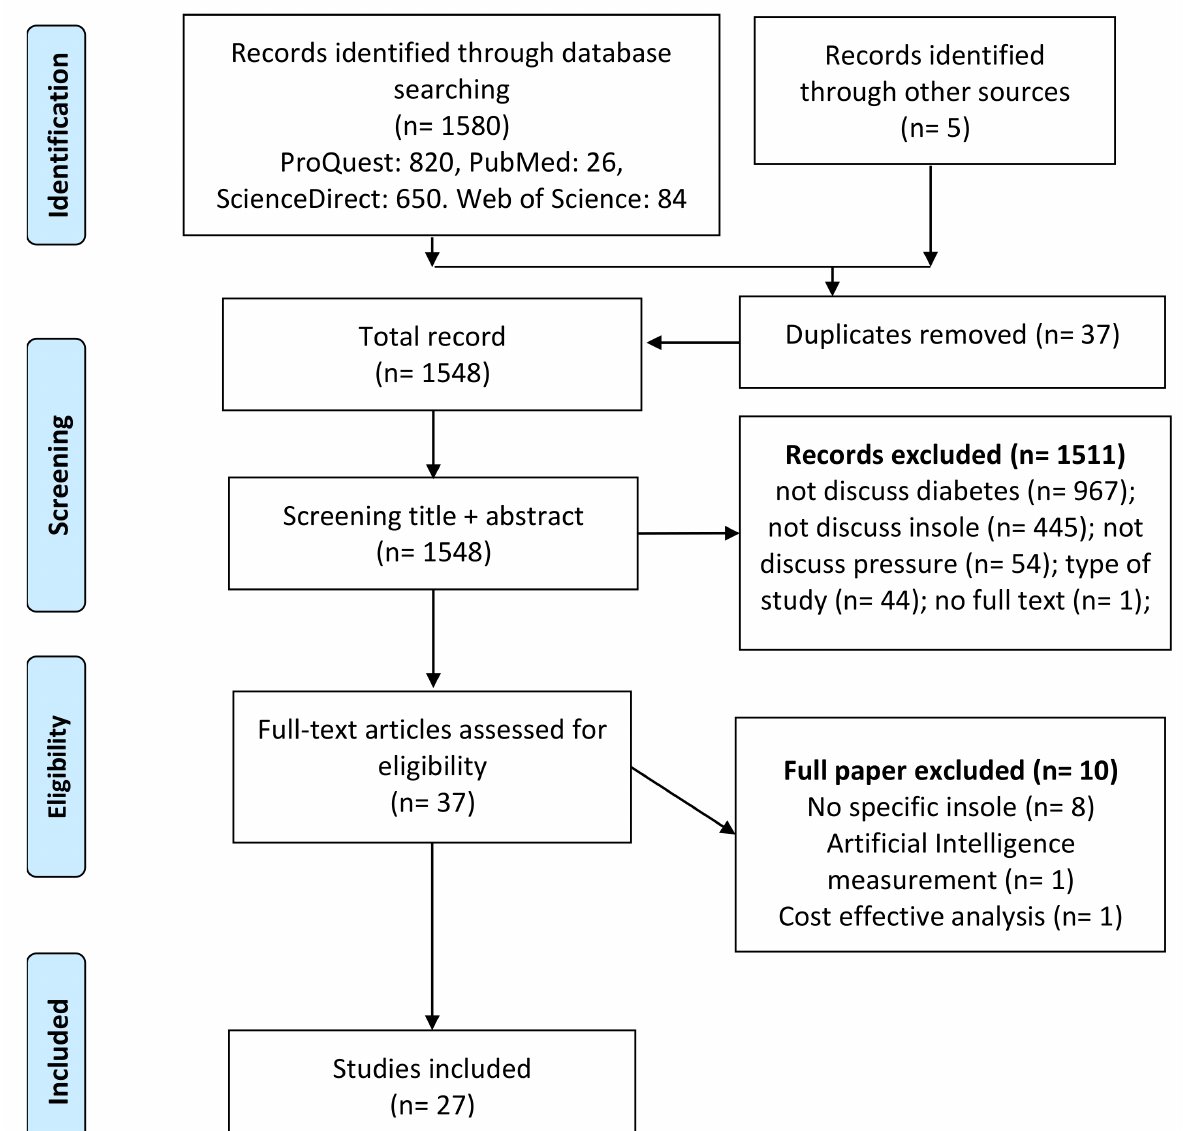
Figure 1. Flow diagram for study